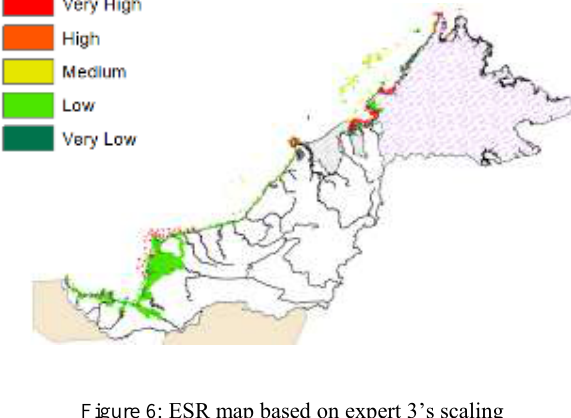
Figure 6: ESR map based on expert 3’s scaling